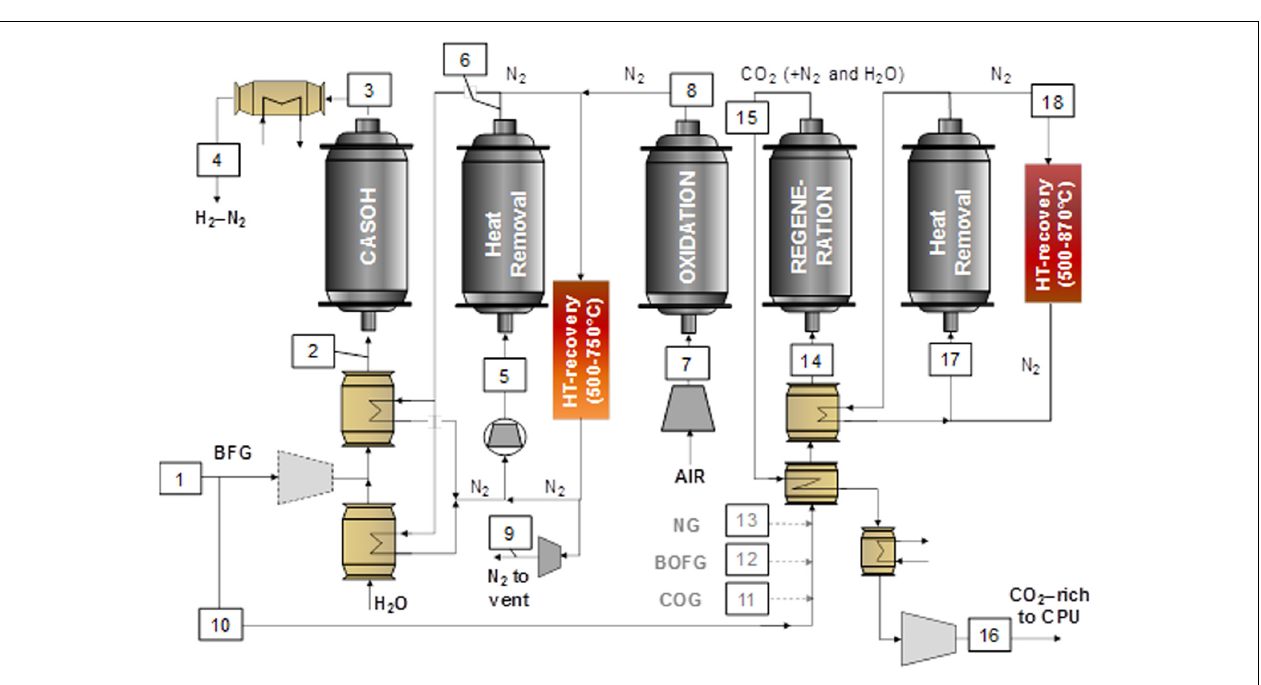
FIGURE 3 | Illustration of the CASOH scheme reaction network using BFG for both H 2 /N 2 production and sorbent regeneration (other low N 2 -content fuel gases can also be used in the regeneration stage to further increase the CO 2 purity in the product